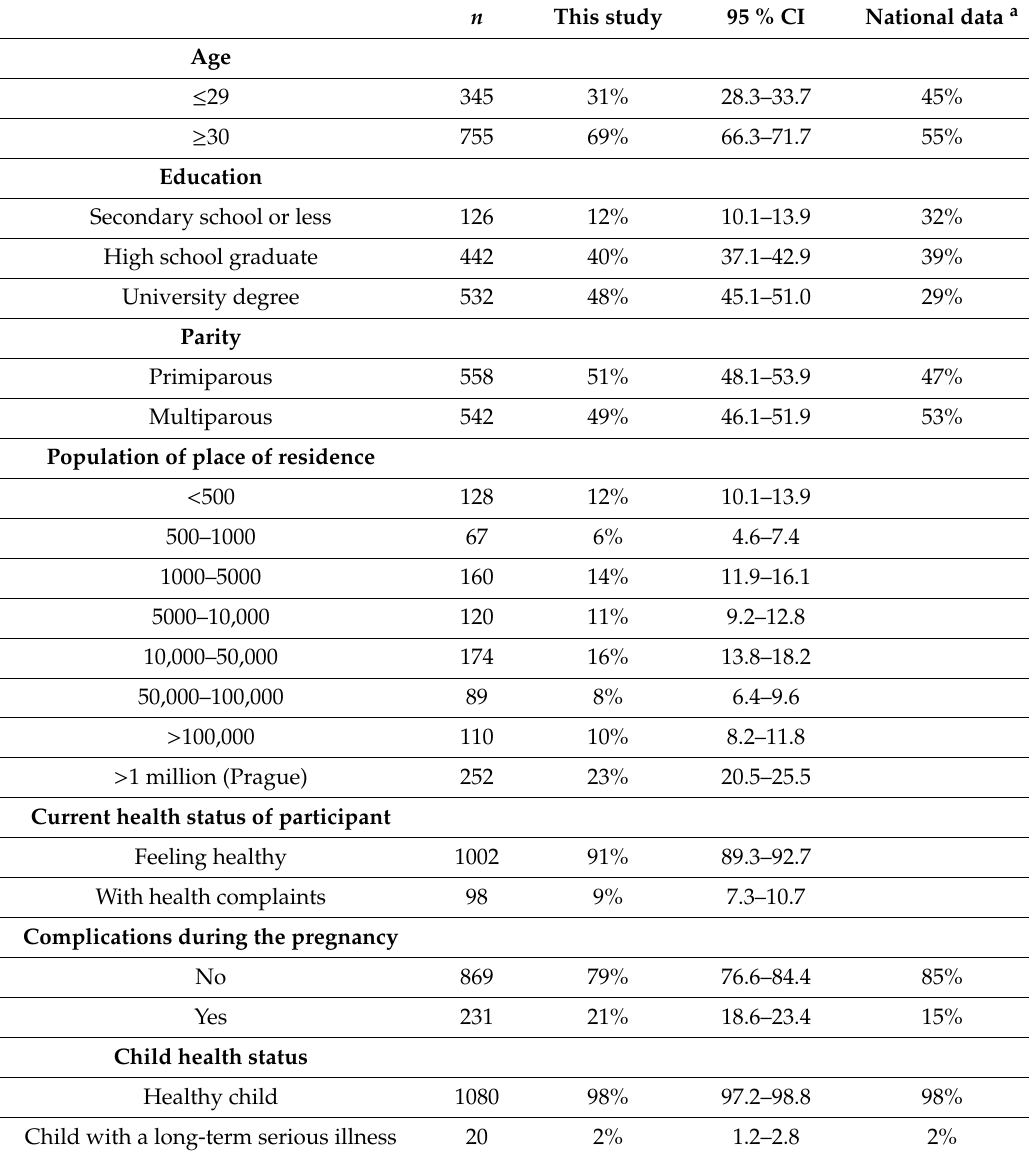
Table 1. Sample characteristics ( n =